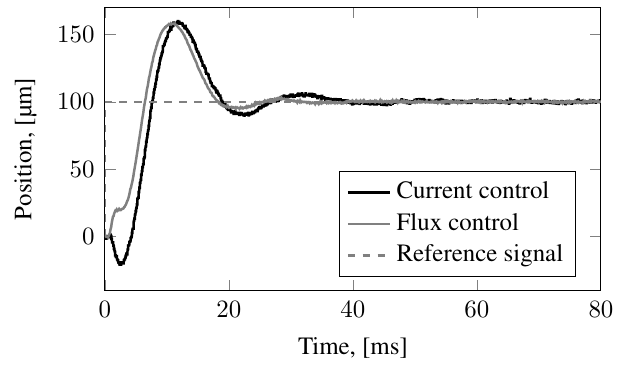
Figure 6. Measured step response at the A-end in the y -direction with a 100 µm magnitude at a